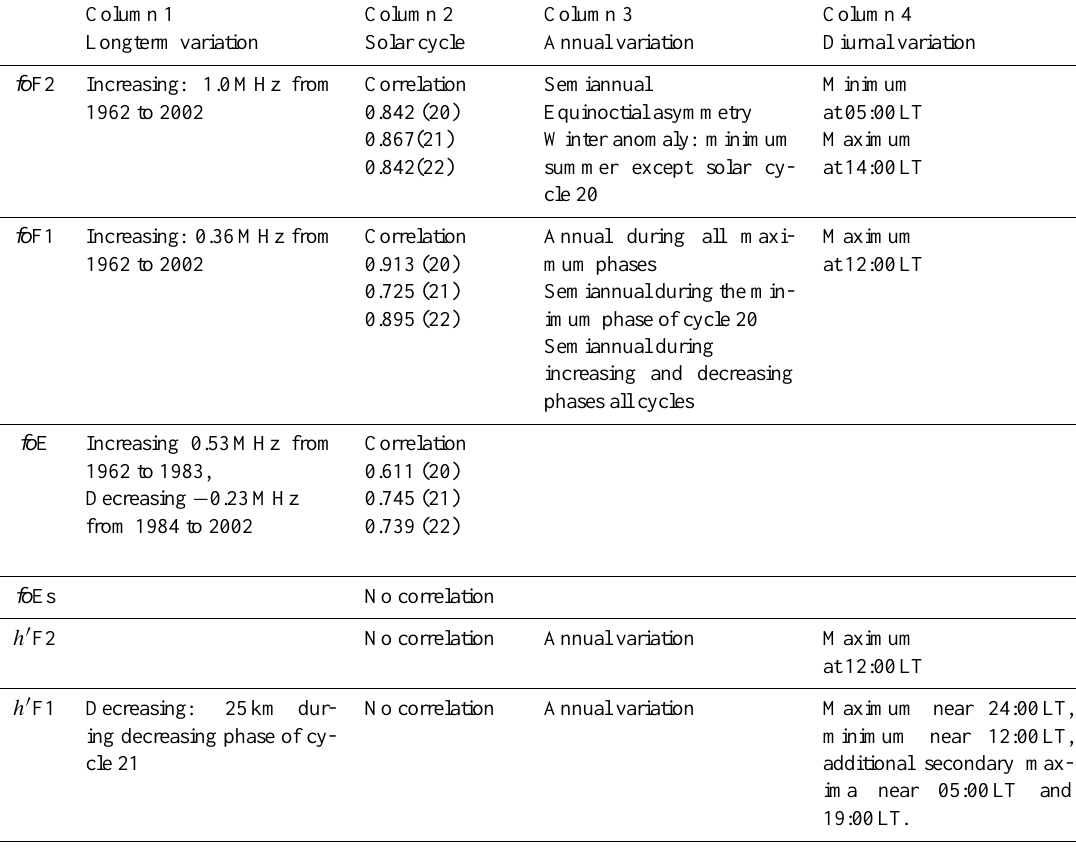
Table 4. Characteristics of ionospheric